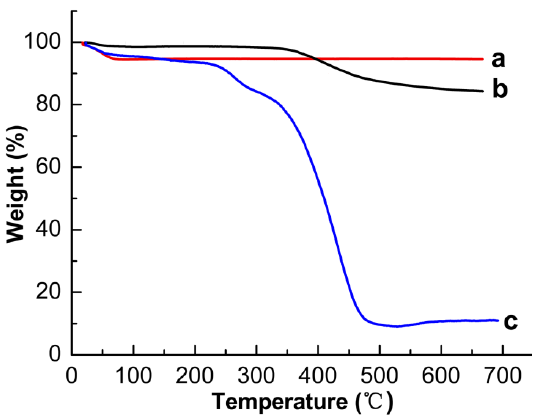
Figure 5. Thermogravimetric weight loss curves of (a) SBA-15; (b) SBA-15-MPS; (c) SBA- 15@MT-MIPs. Table 2. Porosities of polymers determined by N 2 adsorption-desorption analysis.